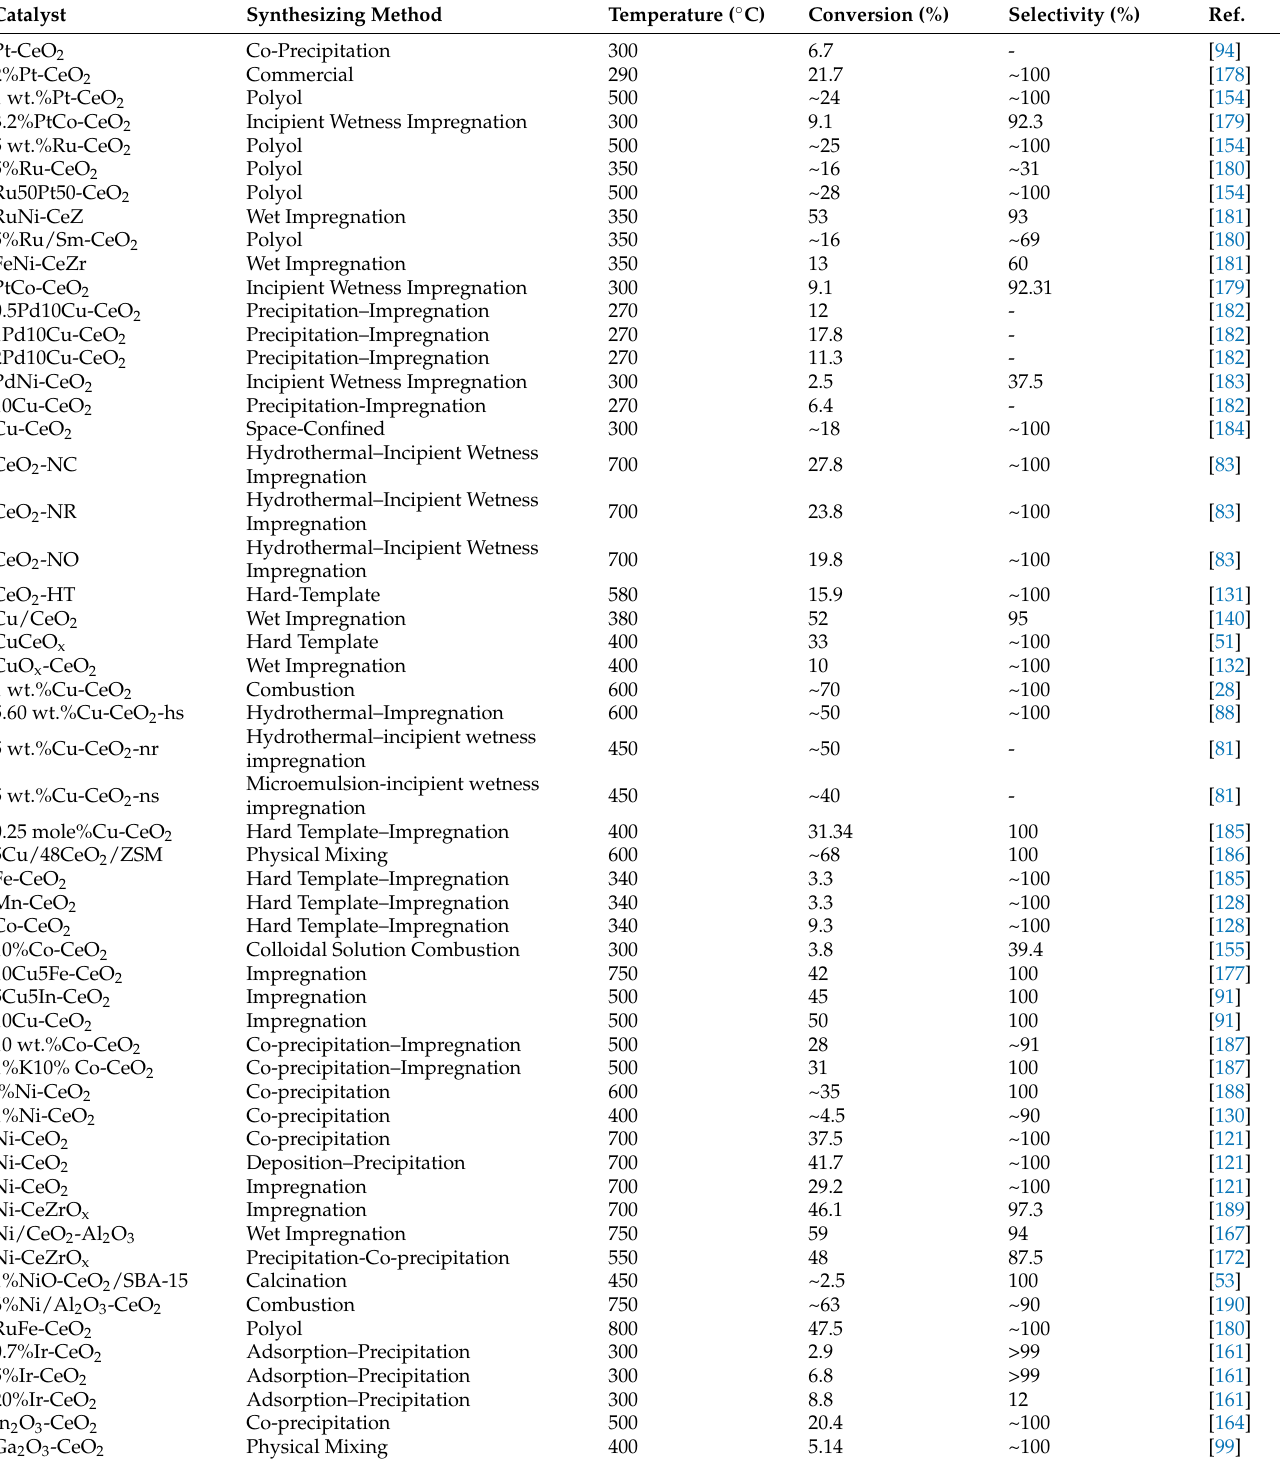
Table 3. Conditions and catalytic performance in RWGS reaction on different kinds of metal-CeO 2